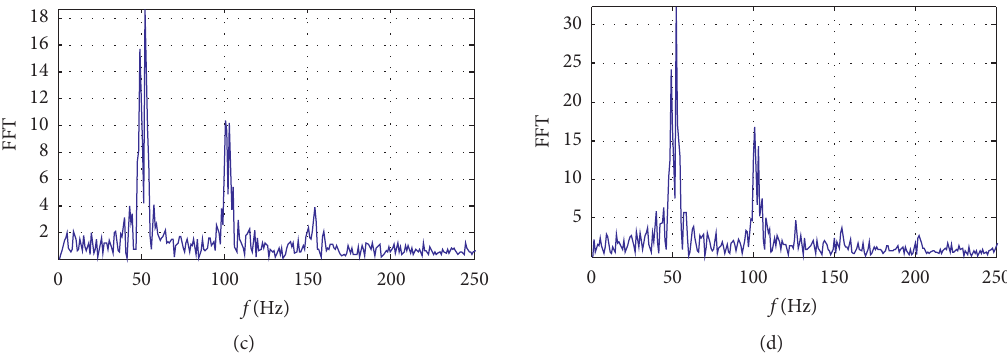
Figure 7: Time-domain and frequency-domain waveforms of the signals after denoising using MF-WD.